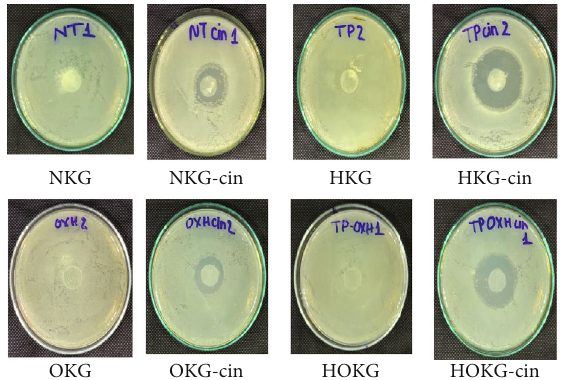
Figure 9: Disc di ff usion test of KG-starch fi lms with and without 5% cinnamaldehyde after 4